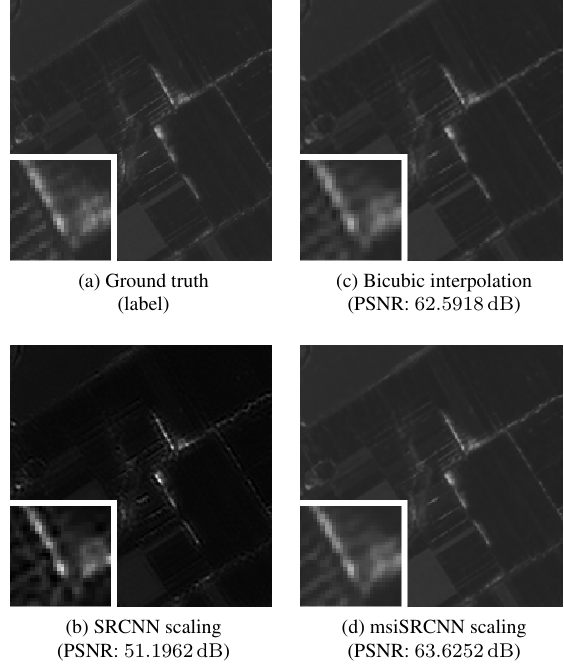
Figure 6: S ENTINEL -2 B03 singleband image scaling layers as inner layers exclusively can be derived